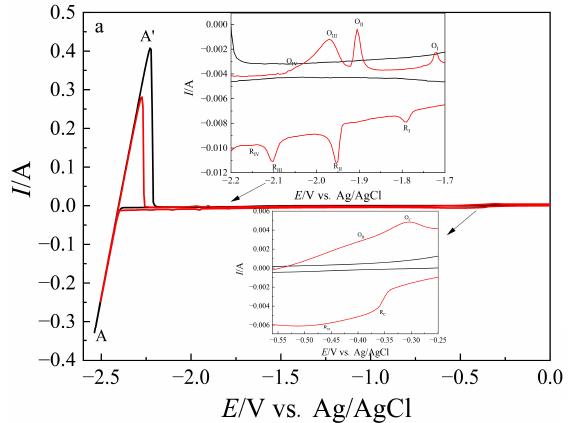
Figure 6. CVs of blank eutectic LiCl-KCl (black line) and molten LiCl-KCl-YbCl 3 -PbCl 2 salts (red line) on the W electrode at 773 K.